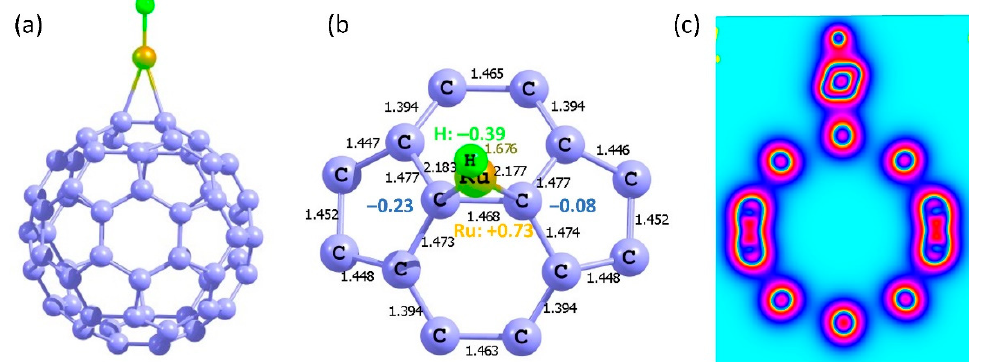
Figure 13. ( a ) Relaxed structure of a single hydrogen atom adsorbed on the Ru-supported C 60 surface ( b ) bond distances and Bader charges on the Ru and its adjacent C atoms and ( c ) charge density plot showing the interaction of hydrogen atom with Ru-supportedC 60 surface.